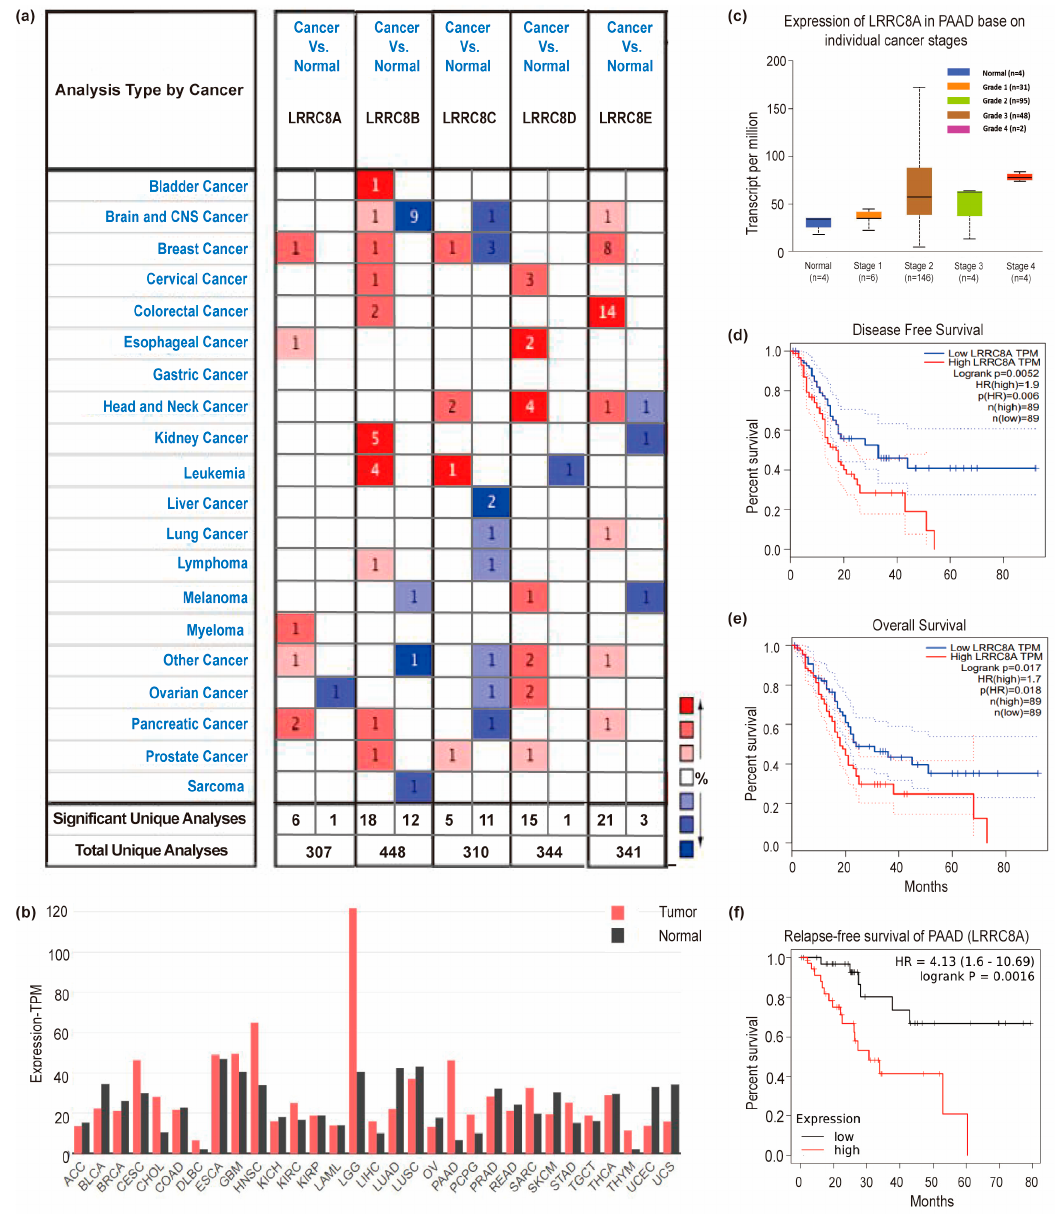
Figure 1. Bioinformatics analyses of LRRC8A in PAAD. ( a ) Pan-cancer analysis of LRRC8A–E expression by ONCOMINE; ( b ) the expression of LRRC8A in PAAD was seven-fold higher than that in normal by GEPIA, Tumor (n = 179), Normal (n = 171); ( c ) LRRC8A expression in PAAD based on individual cancer stages; ( d , e ) the DFS and OS of patients with PAAD with a high LRRC8A expression were significantly worse than those with a low LRRC8A expression; ( f ) the RFS of patients with PAAD with a high LRRC8A expression were significantly worse than those with a low LRRC8A